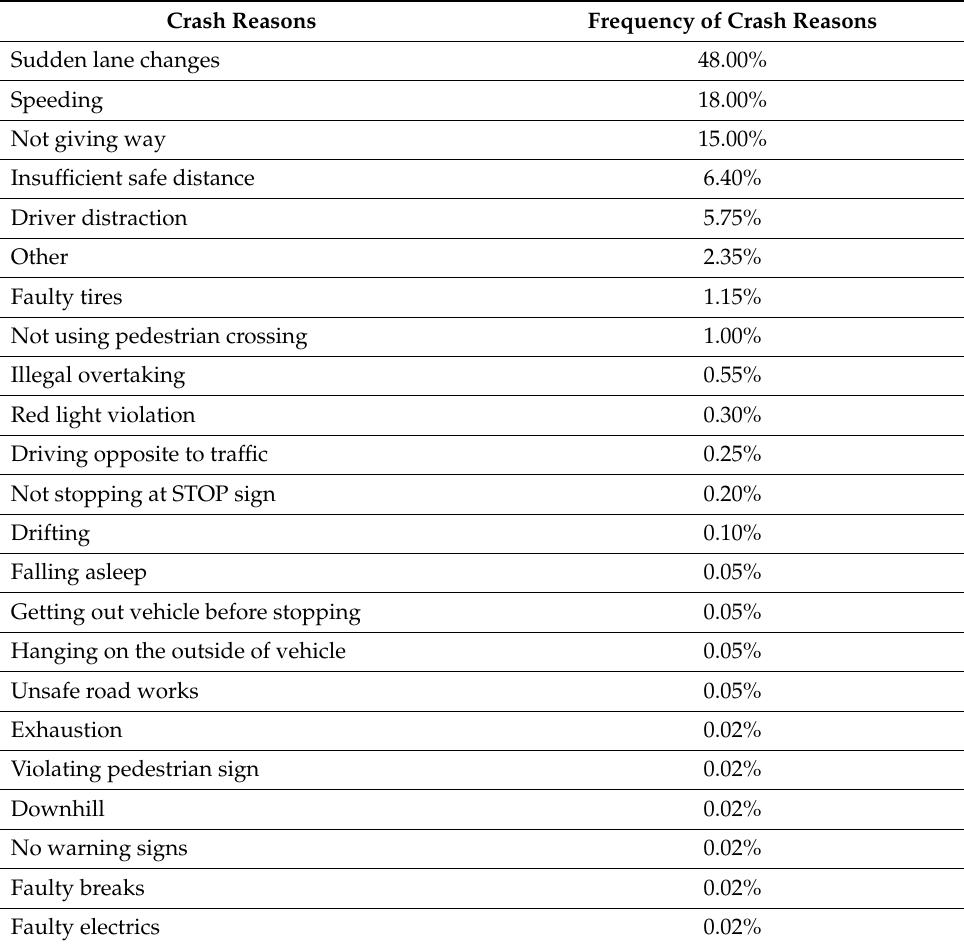
Table 2. Frequency of crash